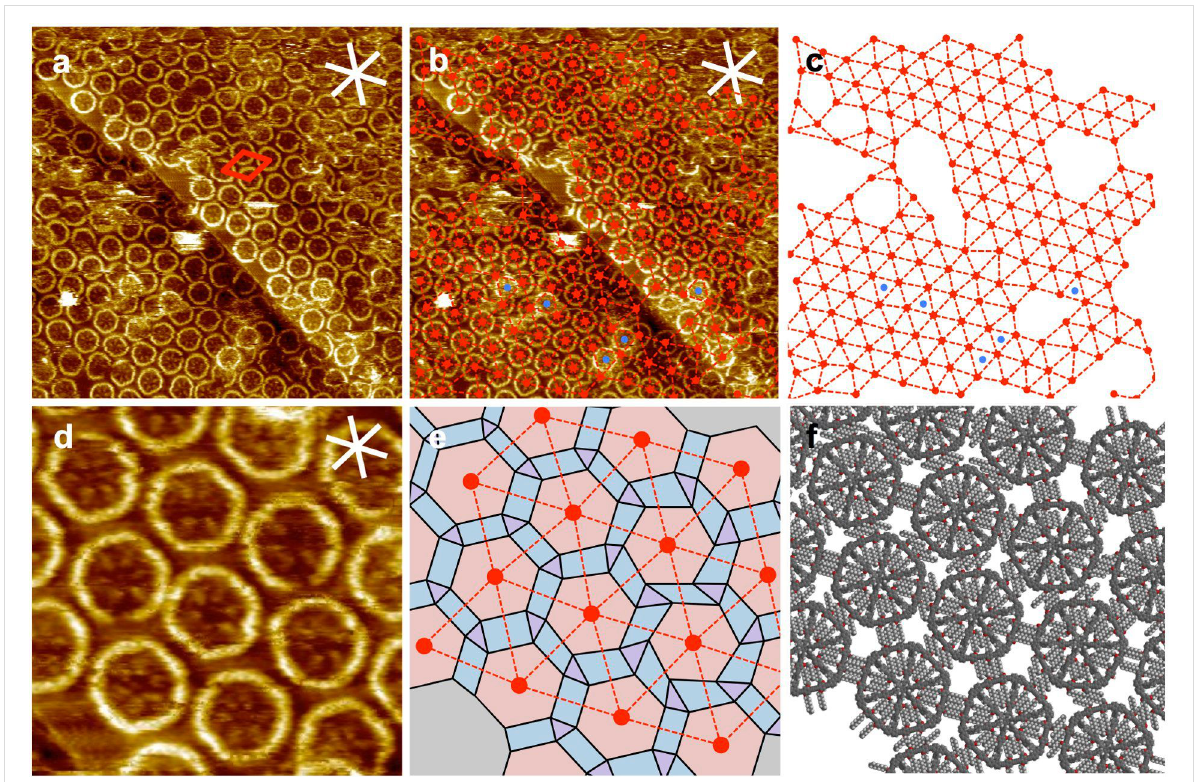
Figure 3: (a)–(f) STM images, mesh, polygon, and supramolecular models of MSW 2 at the OA/HOPG interface. (a) The overview STM image (88.6 × 88.6 nm 2 , V S = − 1.5 V, I t = 10 pA) shows an adlayer in which the circular shapes of the MSW rims and features of the central hub/spoke system are recognizable. A (nominal) unit cell of a = b = 6.9 ± 0.2 nm, γ ( a , b ) = 60 ± 2° (red lines) is approximated. (b) A copy of the STM image shown in (a), where the centers of all MSWs are marked by red dots, and dashed lines are drawn to connect all adjacent dots, so that a network struc- ture results, which is shown without the STM image in (c). (d) A more detailed STM image (23.0 × 23.0 nm 2 , V S = − 1.5 V, I t = 10 pA) confirms the high variation of rim–rim distances. (e) A mesh model is drawn similar as in (b). The centers of equilateral hexagons are placed at the positions of the red dots, and the orientation of each hexagon is fitted to match the MSW orientation (by rotation). The corners of adjacent hexagons are connected by solid black lines to form triangles and tetragons, the variation of the shapes of which points out the high degree of disorder. (f) The data obtained in (d) and (e) is translated into a supramolecular model. The alkoxy side-chains are subsequently added to match the expected directions along the HOPG main axes [10,11], showing that the intermolecular interactions cannot be described by (only) one side-chain interdigitation motif. The MSWs were deposited from a 10 − 5 M solution, and the sample was thermally annealed for 30 s at 80 °C.